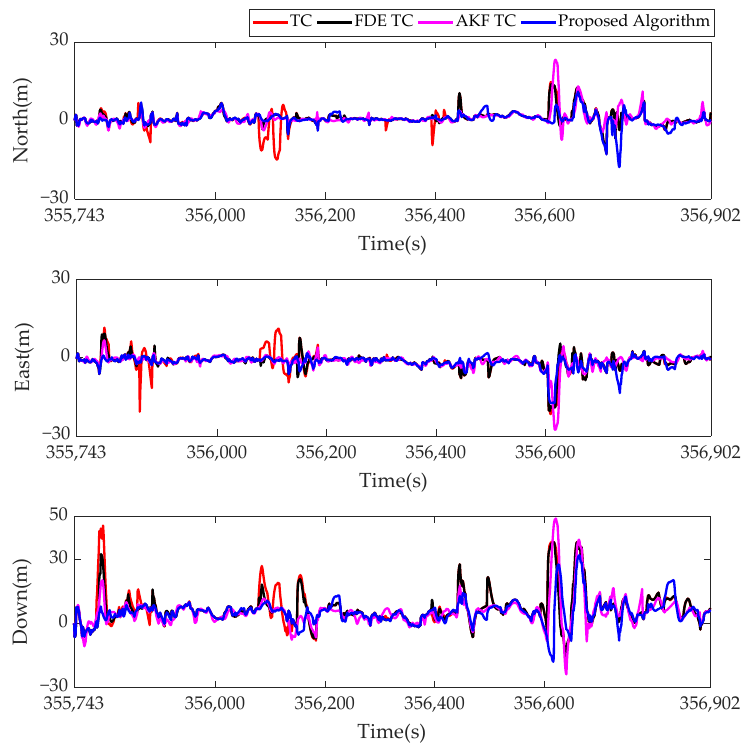
Figure 8. The position error of TC, FDE TC, AKF TC, and the proposed algorithm in field test.